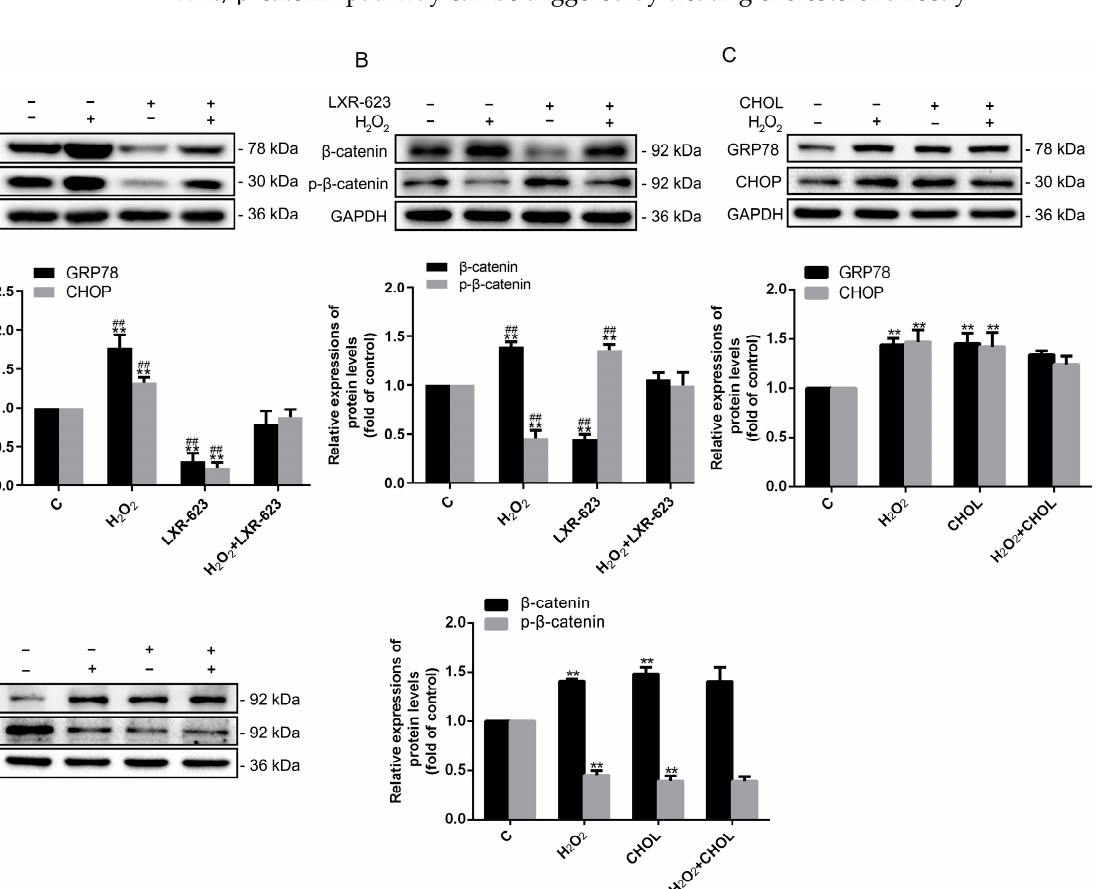
Figure 5. LXR-623 can inhibit ER stress and the Wnt/ β -catenin pathway by promoting cholesterol efflux, and adding cholesterol extracellularly can induce ER stress and activate the Wnt/ β -catenin pathway by increasing the deposition of intracellular cholesterol. ( A – D ) The expressions of GRP78, CHOP, β -catenin, and p- β -catenin were detected by Western blot. n = 3, ** p < 0.001 vs. the C group; ## p < 0.001 vs. the H 2 O 2 + LXR-623 group. The C (control) group of LXR-623 and cholesterol were treated by DMSO and chloroform, respectively; H 2 O 2 , cells treated with H 2 O 2 (500 µ mol/L) for 24 h; LXR-623, cells treated with LXR-623 (5 µ mol/L) for 24 h; H 2 O 2 + LXR-623, cells treated with LXR-623 (5 µ mol/L) for 2 h and then treated with H 2 O 2 (500 µ mol/L) for 22 h; CHOL, cells were treated by cholesterol (100 µ mol/L) for 24 h; H 2 O 2 + CHOL, cells were firstly treated by cholesterol (100 µ mol/L) for 2 h, and then H 2 O 2 (500 µ mol/L) was used to treat cells for 22